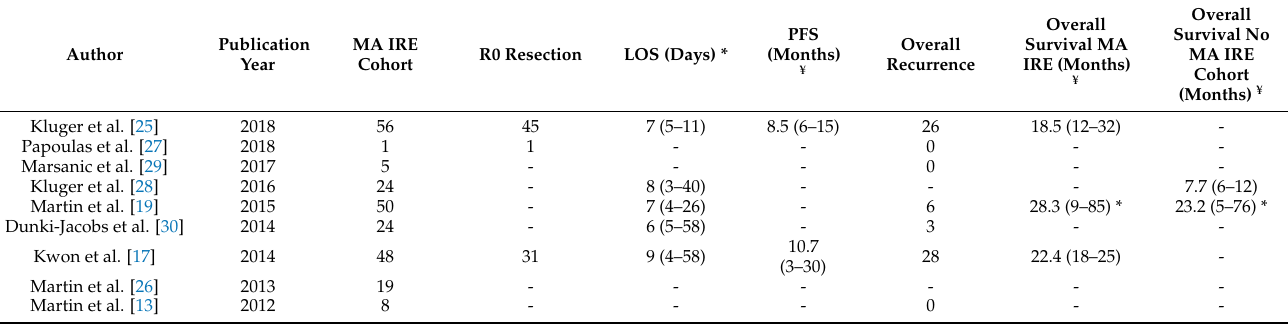
Table 3. Outcomes reported in all included